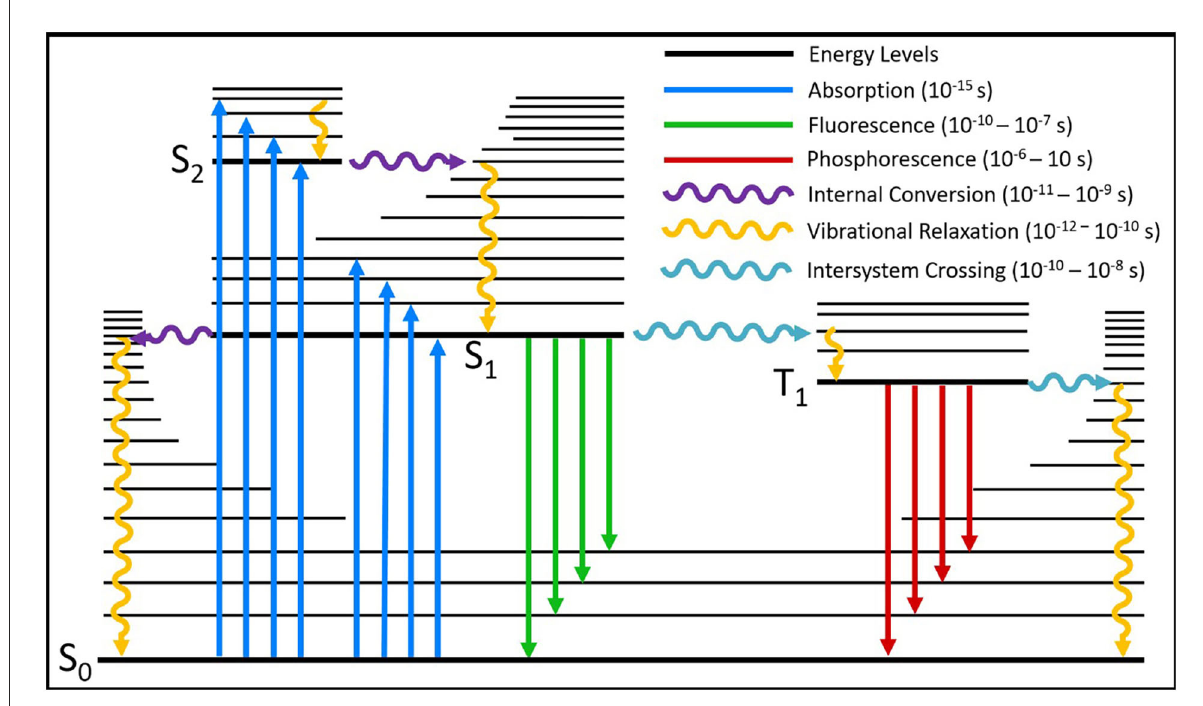
FIGURE2 A typical Jablonski diagram showing the possible radiative and non-radiative transitions (IUPAC,